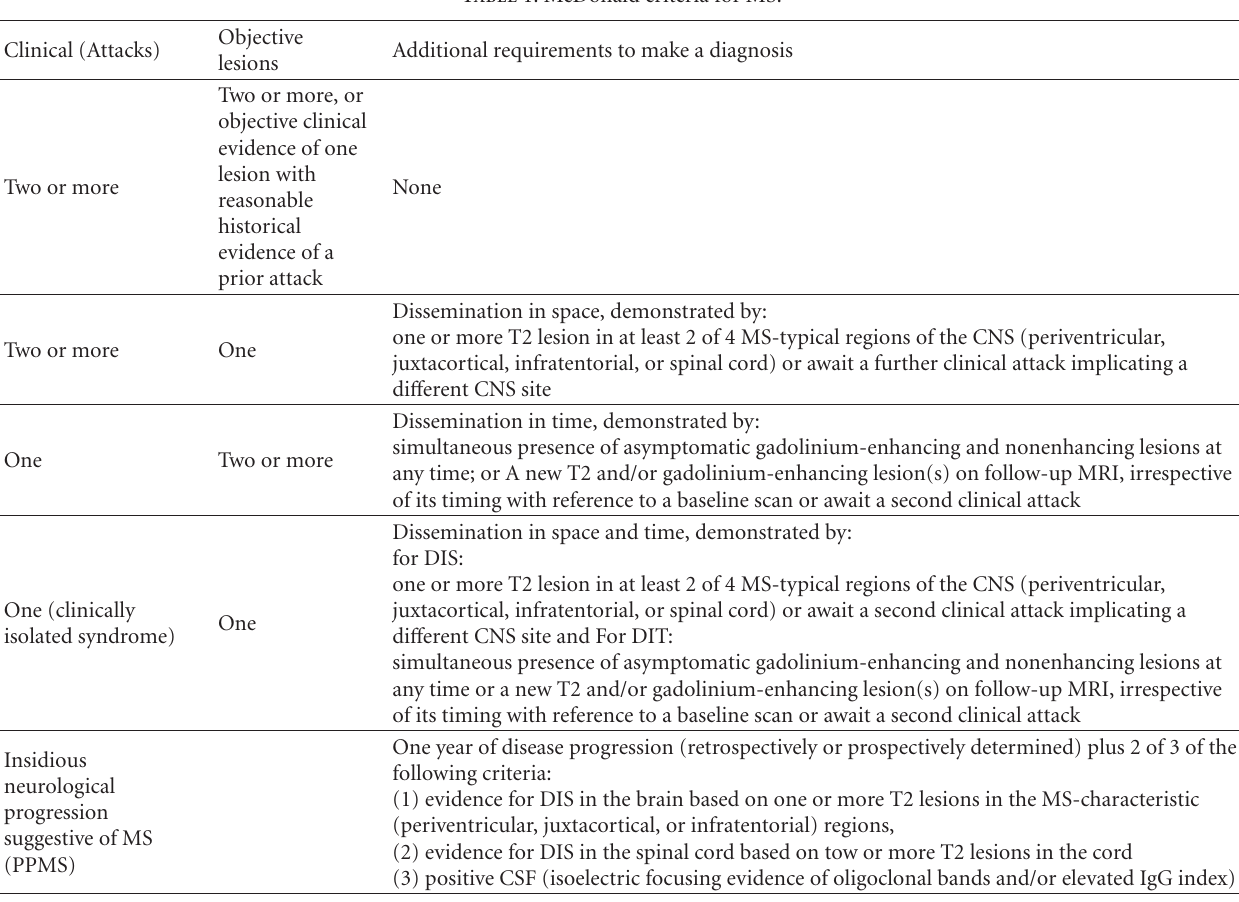
Table 1: McDonald criteria for